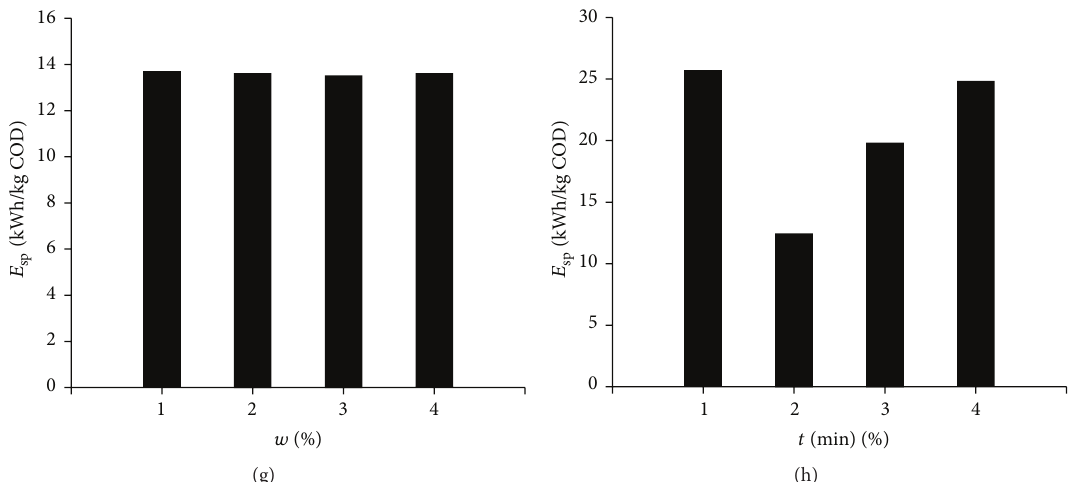
Figure7:VariationofCODandpowerconsumptionindifferentsalinitywastewaterovertime.(a)VariationoftheoreticalCODconcentration over time. (b) Removal rate variation of theoretical COD in different electrolyte concentration phenol wastewater over time. (c) Measured